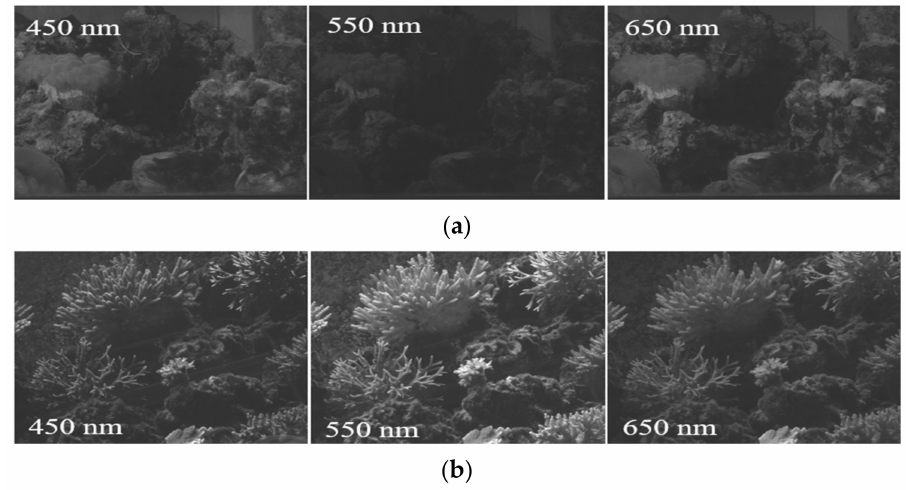
Figure A1. Examples of spectral images under white light. ( a ) Plerogyra Sinuosa . ( b ) Acropora